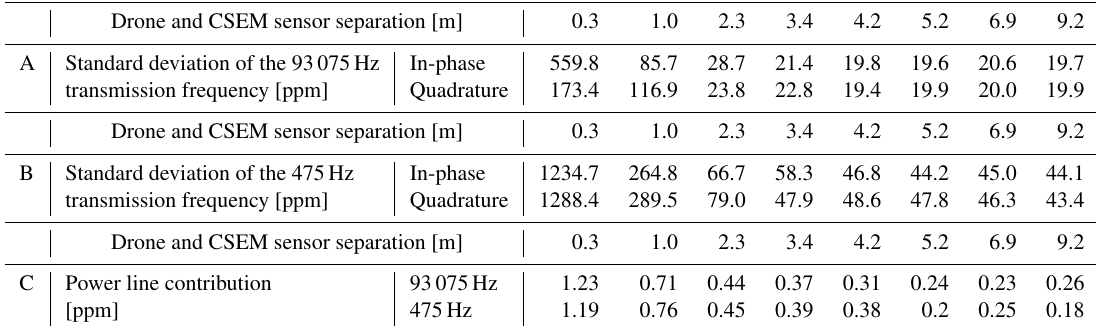
Figure 7. Results of Test 5. The standard deviation is calculated for 91275 and 475Hz with one additional transmitted frequency with decreasing spacing. Note that no notable effect is in 475Hz, while the standard deviation in 91275Hz increases with increasing spacing. Table 2. A collection of values from Test 6. We can read from the numbers that at around 4.2 to 5.2m, the noise from the drone is no longer visible in the